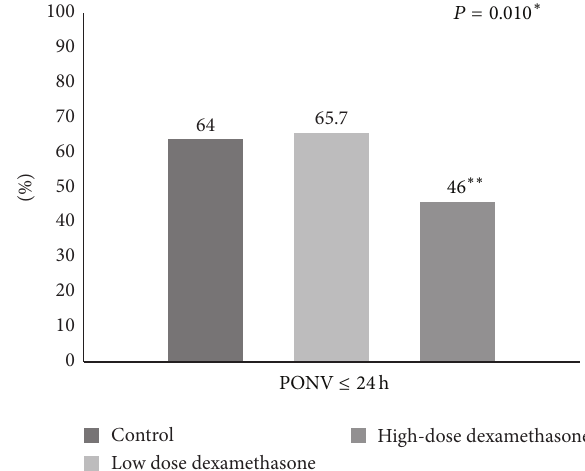
Figure 2: The incidence of postoperative nausea and vomiting. ∗ Chi-squared test. ∗∗ Statistically significant by post hoc analysis. PONV: postoperative nausea and